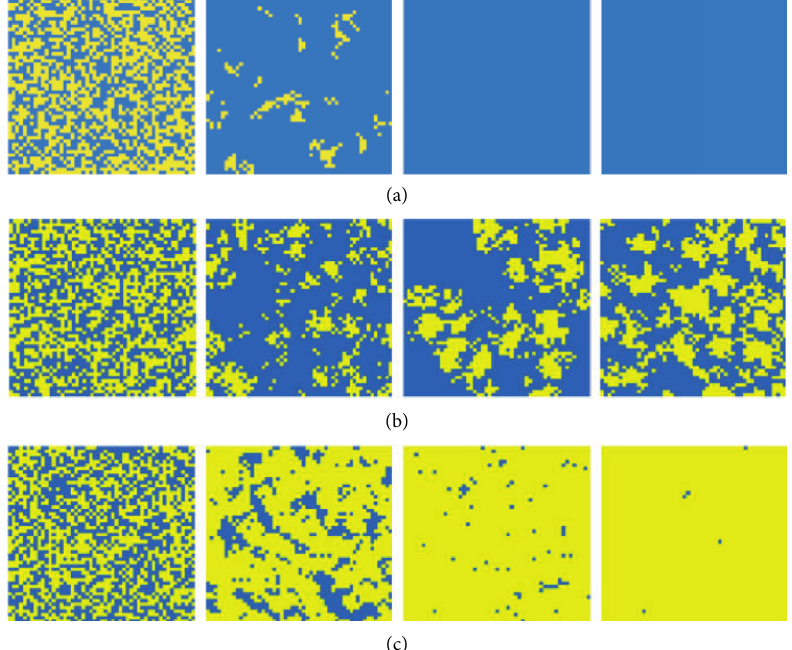
Figure 12: Characteristic snapshot of cooperators (yellow) and defectors (blue) for different values of the parameters u and α . (a) The traditional type ( u � 0 and α � 0), (b) the coexistence of environmental heterogeneity and preference ( u � 0.2 and α � 1), and (c) the more considerable heterogeneity of environment and environmental preference ( u � 0.7 and α � 4). From left to right, the simulation steps are 0, 5, 50, and 500. The depicted are obtained for b �